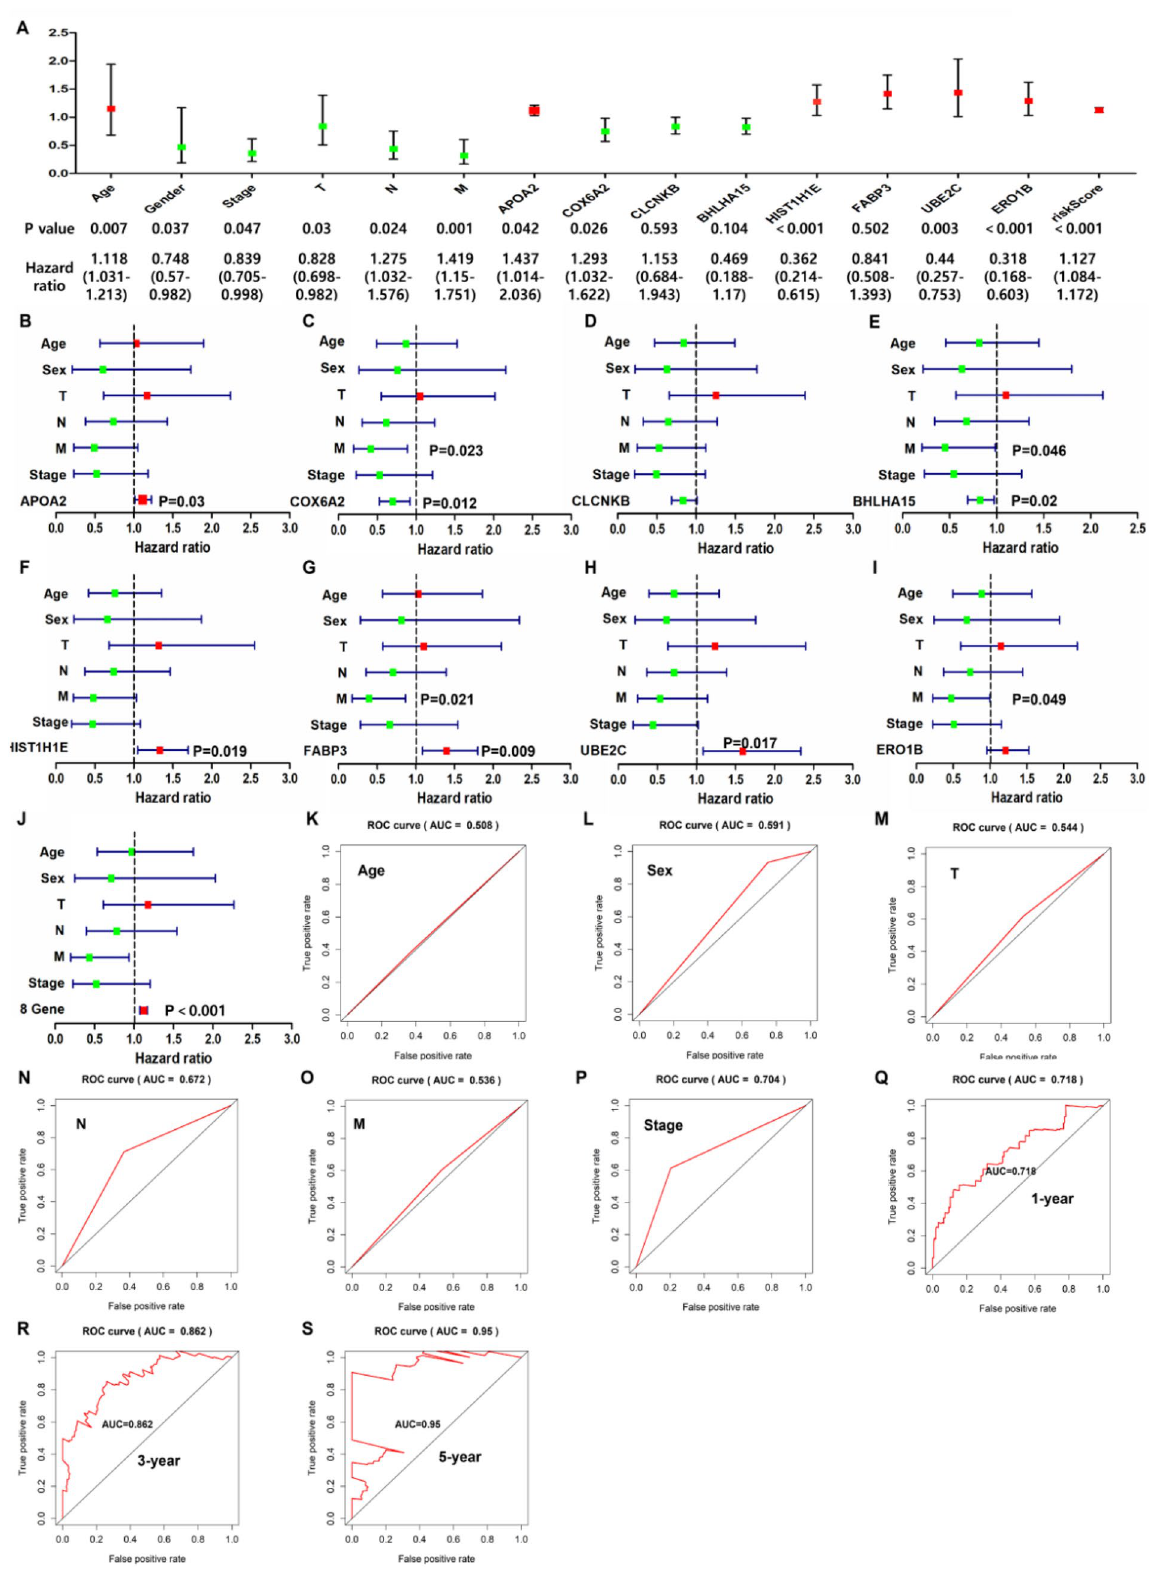
Figure 8. Evaluation of eight gene models as independent predictors. ( A ) ROC curve with comprehensive risk scores as a predictor. ( B - J ) Multivariate analysis of eight gene individuals and comprehensive risk scores involving patient characteristics. ( K - S ) ROC curve. The comprehensive risk scores of the eight genes under the 1-year, 3-year and 5-year curves were 0.718, 0.862 and